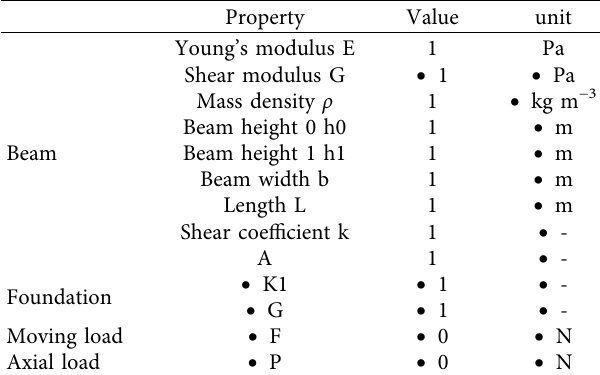
Figure 2: Beam divided into N grid points. Table 1: Temporary governing